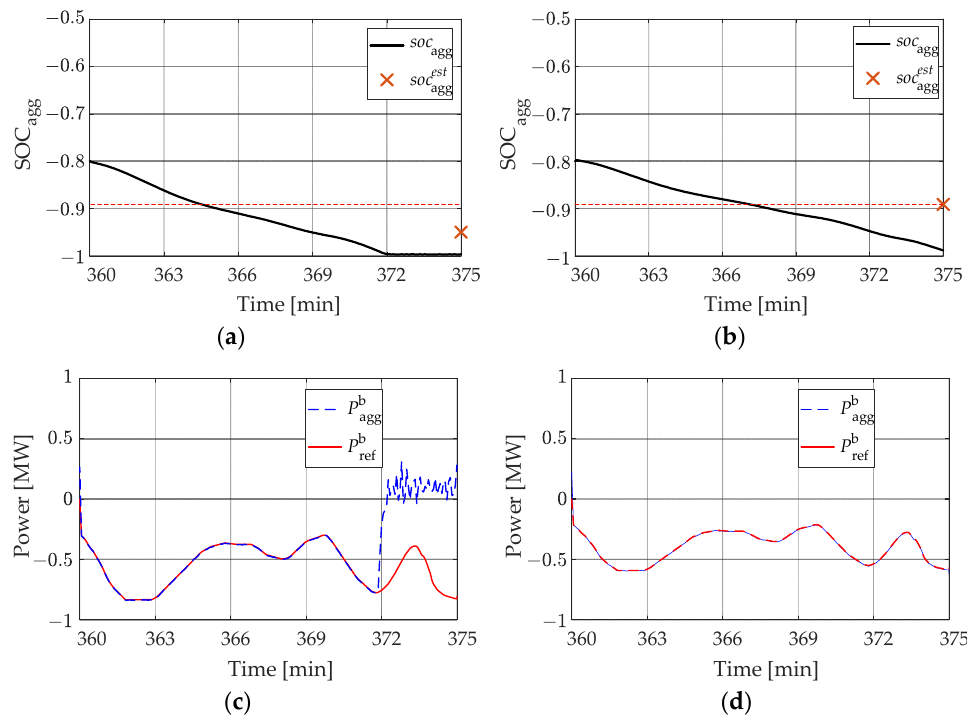
Figure 8. Tracking result in the presence of high baseline power prediction error ( a ) soc agg evolution with soc agg es t = − 0.95. ( b ) SOC agg evolution with soc agg est = − 0.89 . ( c ) Tracking of a regulation signal with soc agg est = − 0.95. ( d ) Tracking of a regulation signal with soc agg est = − 0.89 .